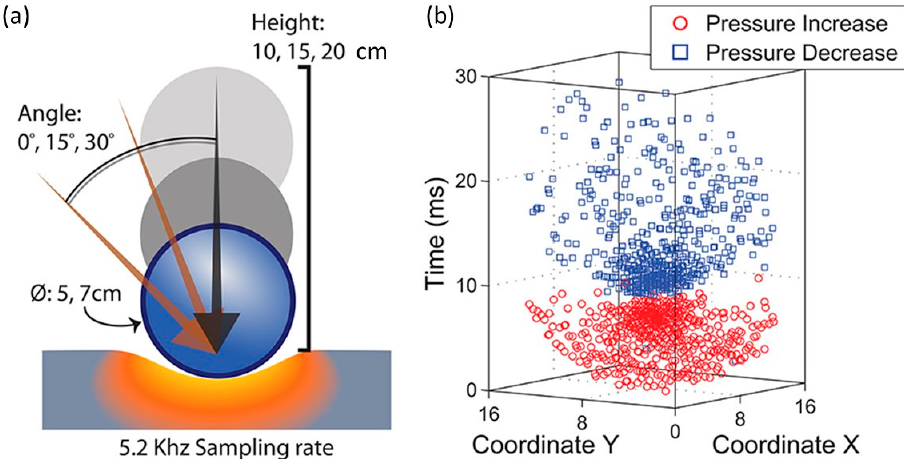
Figure 3. ( a ) Ball dropped on sensor substrate under various physical conditions. ( b ) Spatiotemporal events captured by sensor array. Reprinted/adapted with permission from Ref. [22]. Copyright 2017, Frontiers.